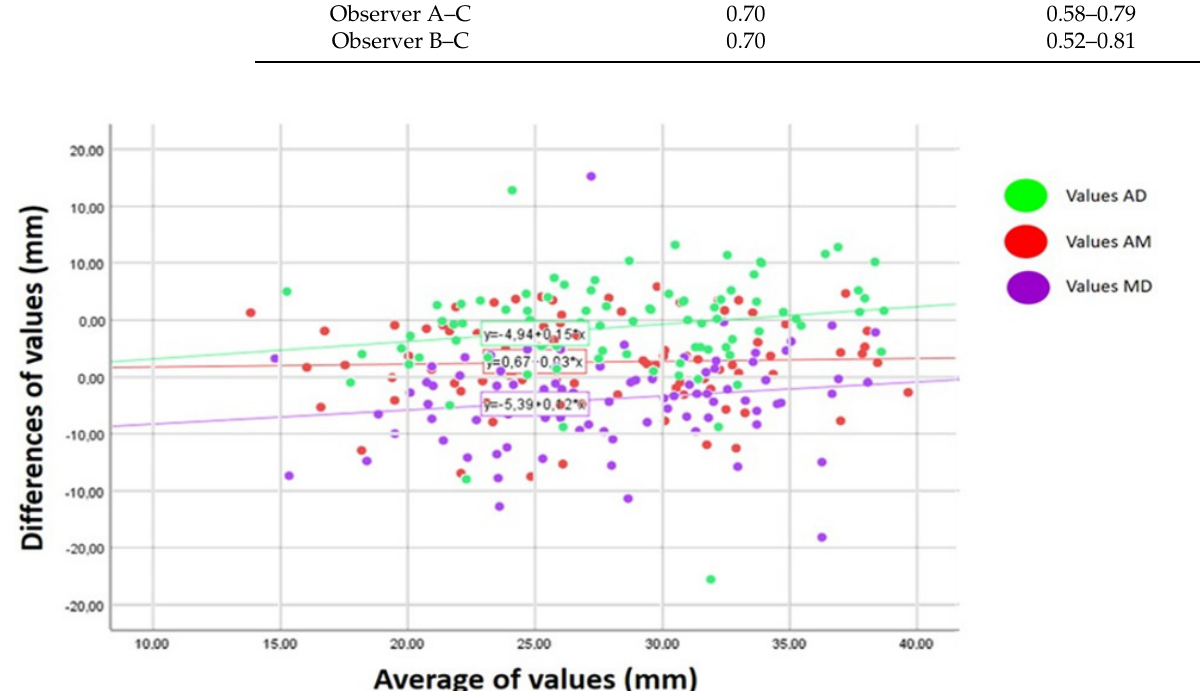
Figure 3. Bland–Altman plot of the mean differences in the mean symphysis–ischial spine distance (SID) values obtained by the observers (A–B, A–C and B–C). The regression lines indicate the trends shown by these differences.